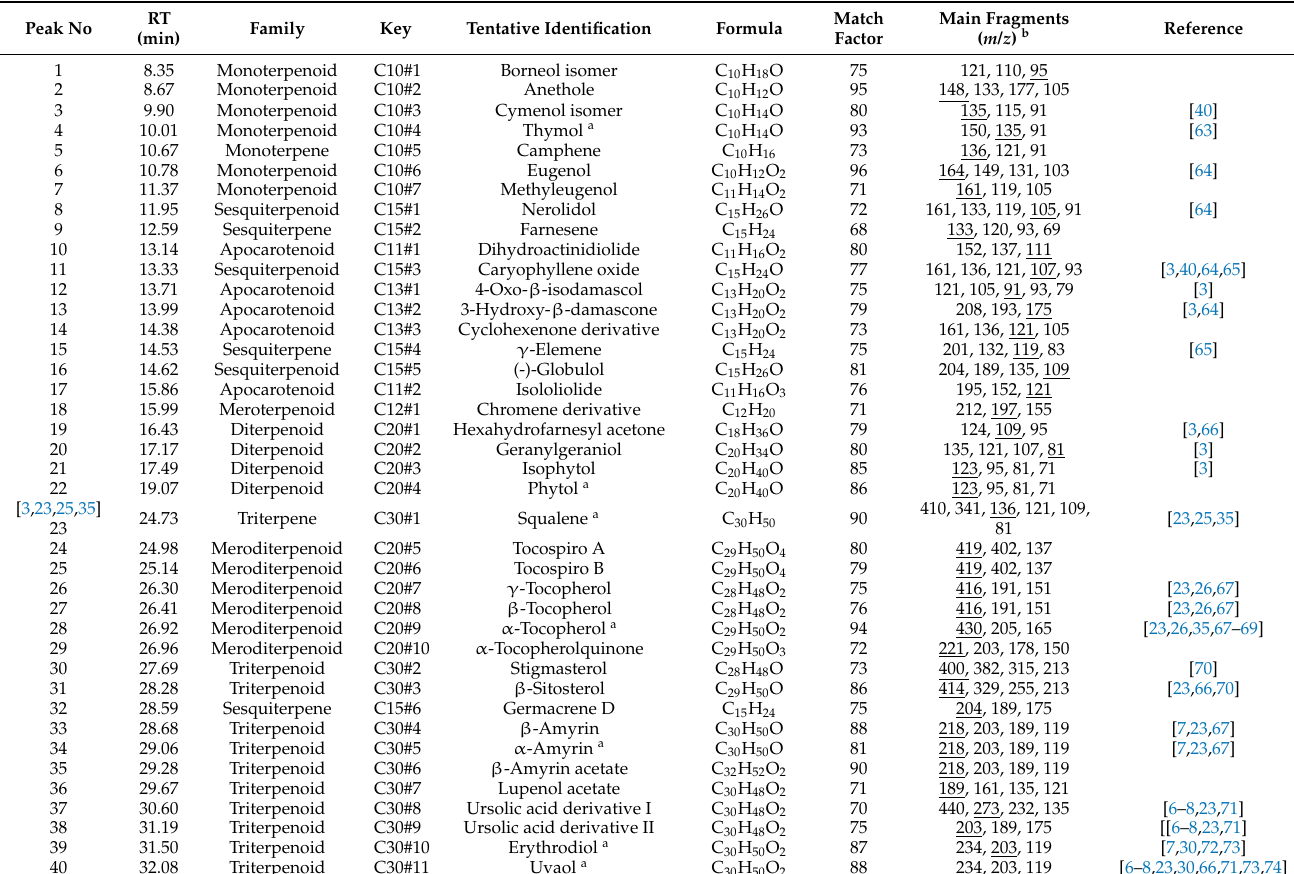
Table 4. Terpenes and terpenoids in olive leaves identified by GC-QTOF-MS using NIST 20 Mass Spectral